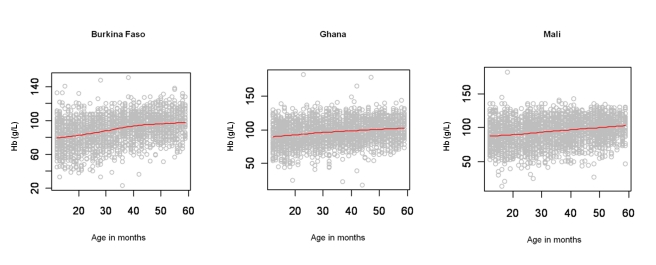
Age patterns of mean haemoglobin concentration.Age (x-axis; in months) patterns of mean Hb (y-axis; g/l) with smooth fit line (red line) generated by a loess smoother, in children aged 1–4 y in the DHS surveys for Burkina Faso (2003), Ghana (2003), and Mali (2006).